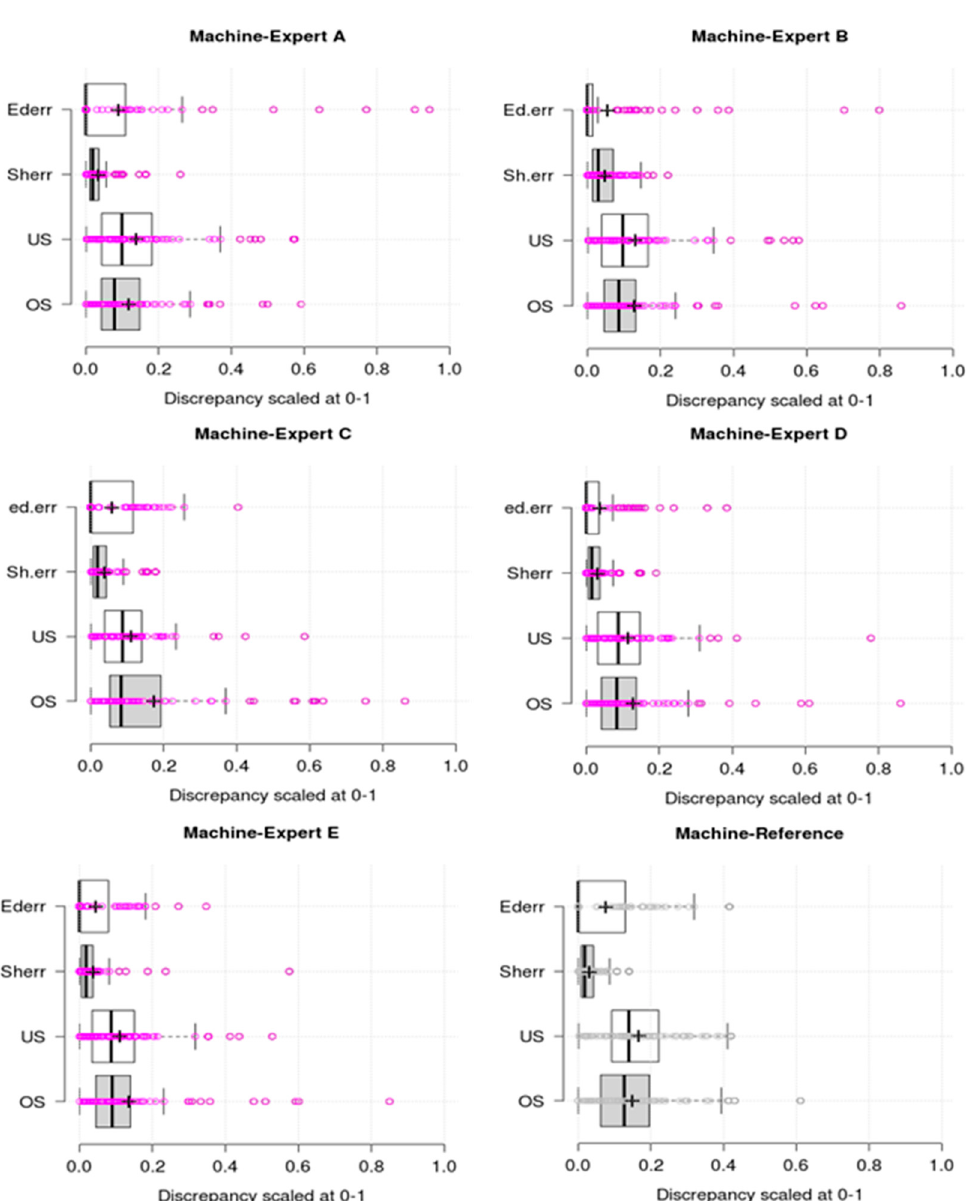
Figure 12. Discrepancies between automated boundaries and manually digitised parcels.